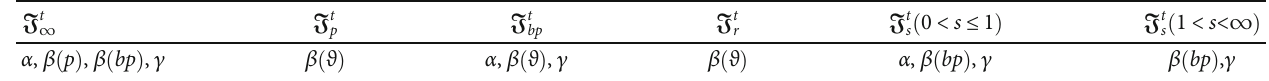
Table 2: Spaces and their duals which are computed in this